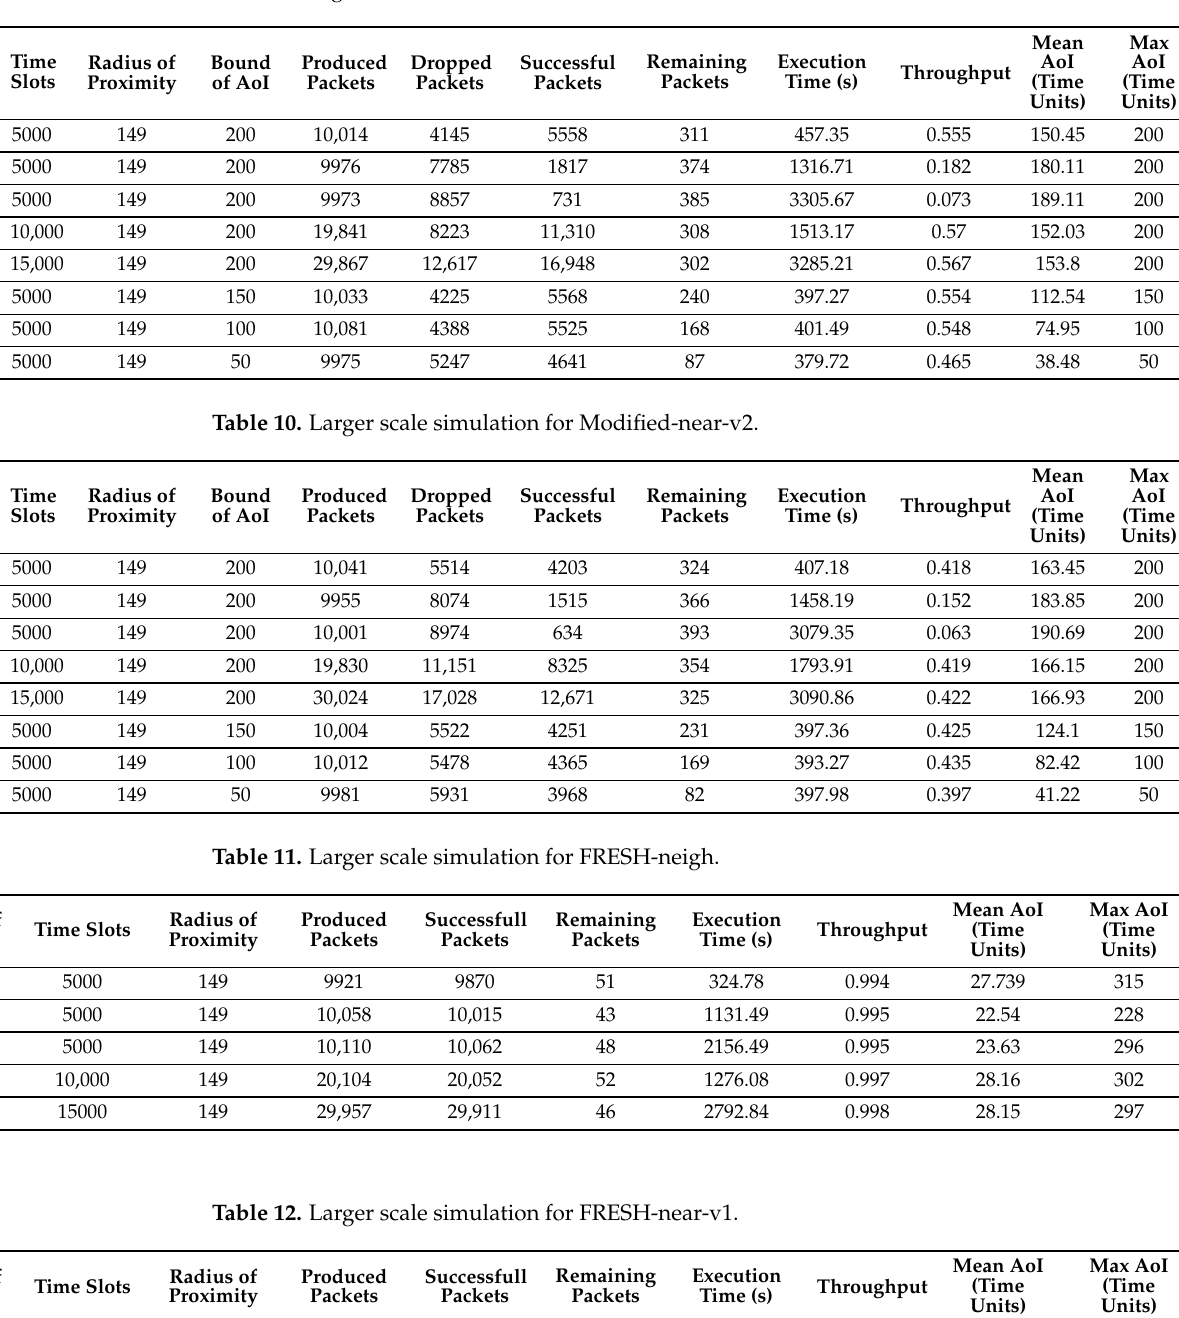
Table 9. Larger scale simulation for Modified-near-v1.